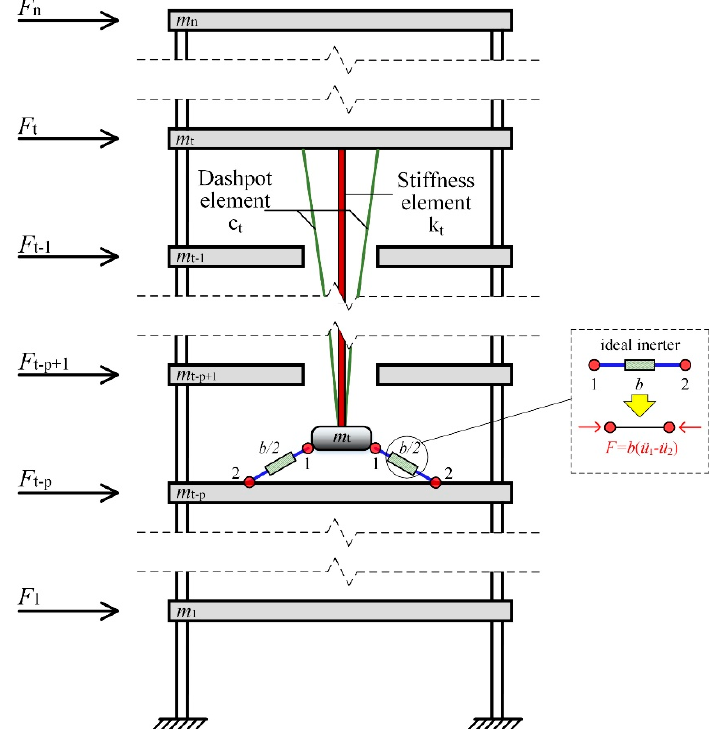
Figure 1. Sketch of Tuned Mass Damper-Inerter (TMDI)-equipped high-rise building modeled as a linear lumped-mass system.